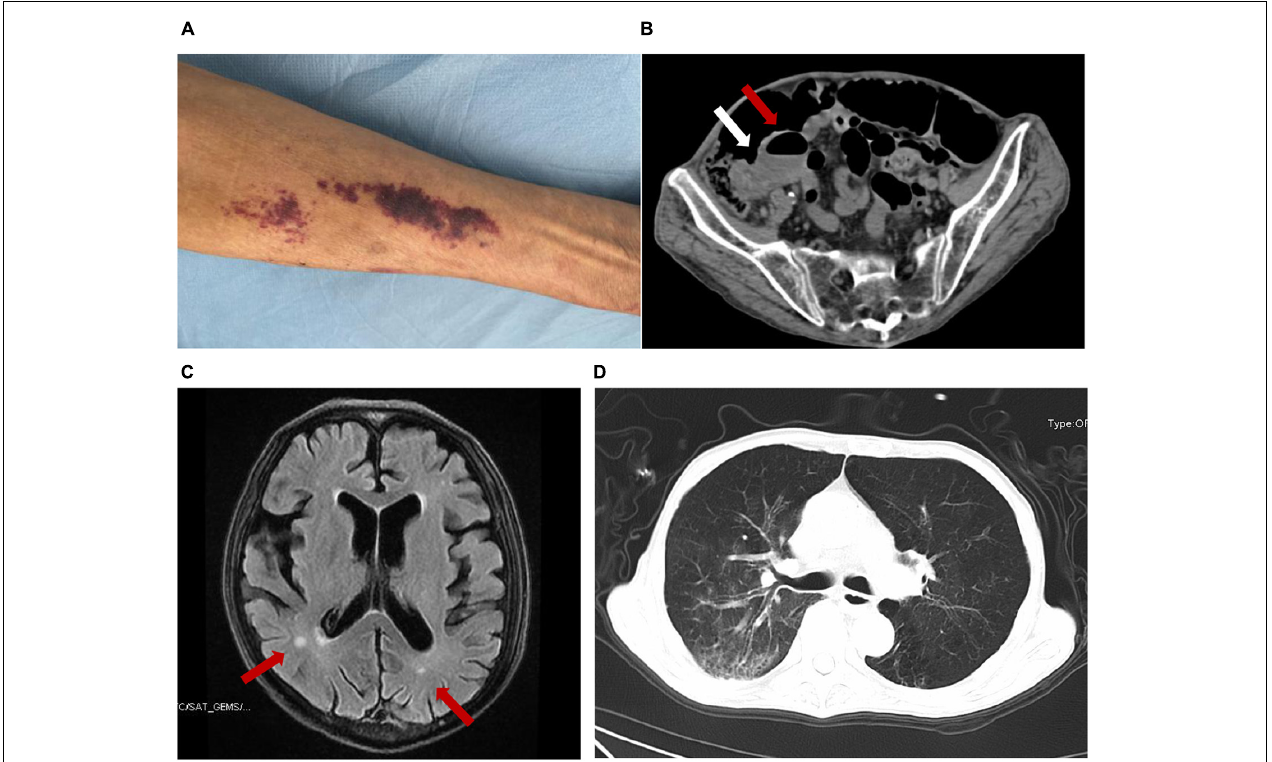
FIGURE 1 | The presentation of this case and the detection of S. stercoralis larvae. Anaphylactoid purpura were present on left upper limb (A) . Abdominal CT imaging showed that the ileocecum was swollen and thickened (white arrow) and the proximal small intestine was obstructed with air-fluid level (red arrow) (B) . Brain MRI showed patches near bilateral ventricles (red arrow) and partial endocranium thickened (C) . Chest CT revealed bronchiectasis with secondary pulmonary infection (D) .